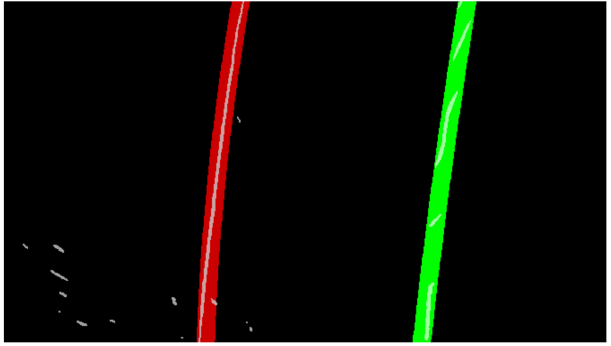
Figure 10. The lane line fitting